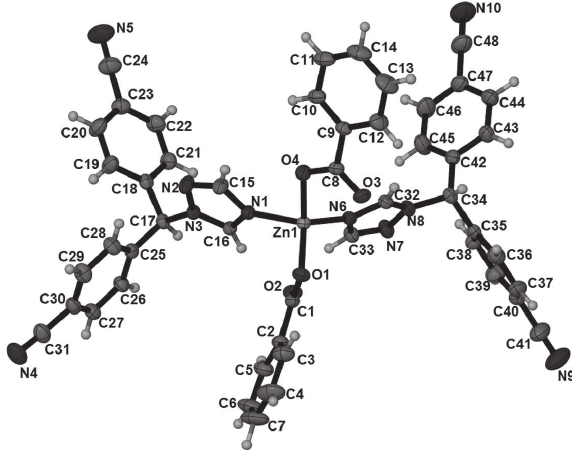
Table 1: Data collection and handling.